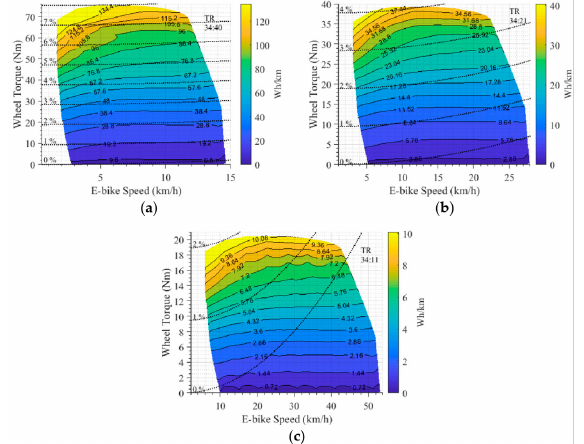
Figure 8. ( a ) Per unit of distance e-bike energy consumption map with 34:40 transmission ratio (TR). ( b ) Per unit of distance e-energy consumption map with 34:21 TR. ( c ) Per unit of distance e-bike energy consumption map with 34:11